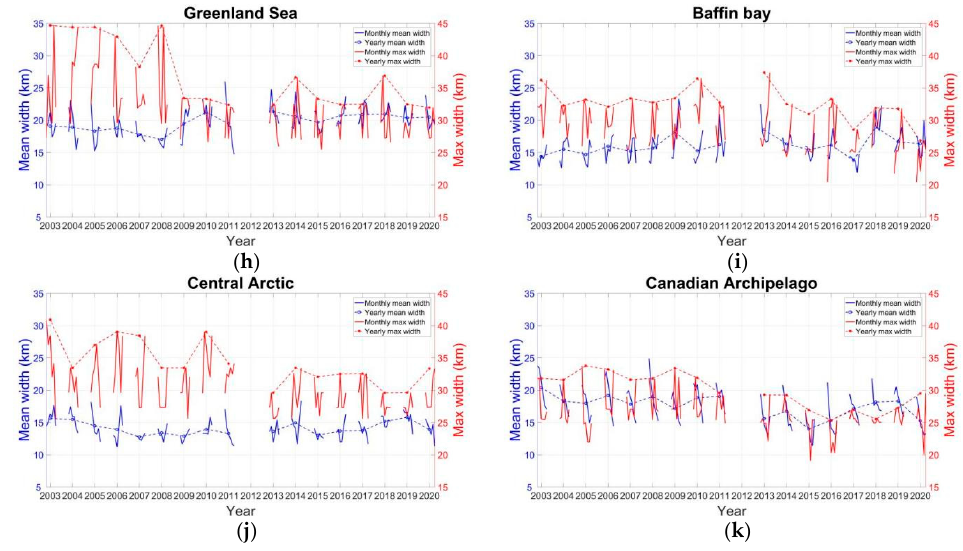
Figure 8. Evolution of max width (red color) and mean width (blue color) in sea ice leads in different regions in the AMSR family data. Solid lines denote monthly mean values. Dashed lines with circles denote annual mean values. ( a ) Whole Arctic, ( b ) Beaufort Sea, ( c ) Chukchi Sea, ( d ) East Siberian Sea, ( e ) Laptev Sea, ( f ) Kara Sea, ( g ) Barents Sea, ( h ) Greenland Sea, ( i ) Baffin Bay, ( j ) central Arctic, and ( k ) Canadian Archipelago. Unit is km.